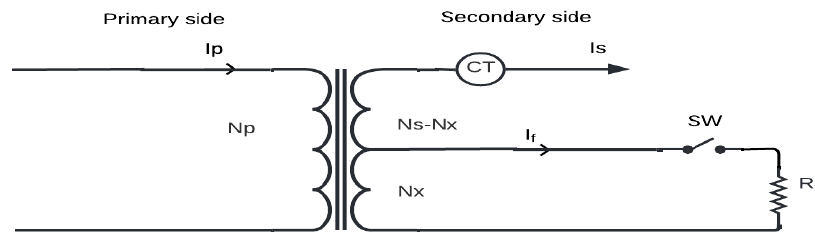
Figure 3. Turn-to-Turn fault